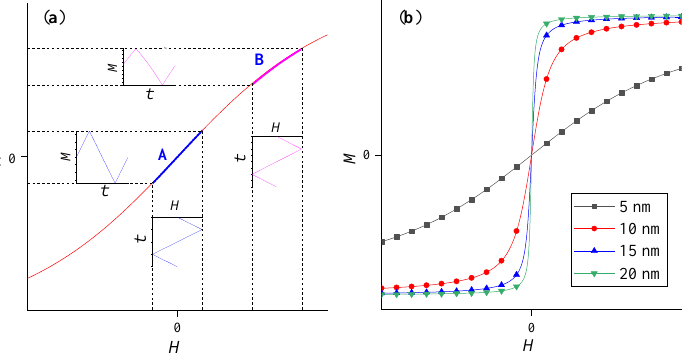
Figure 3. ( a ) M–H magnetization curve of MNP in triangular wave magnetic field with and without DC bias magnetic field. ( b ) M-H magnetization curves of MNP with different sizes.